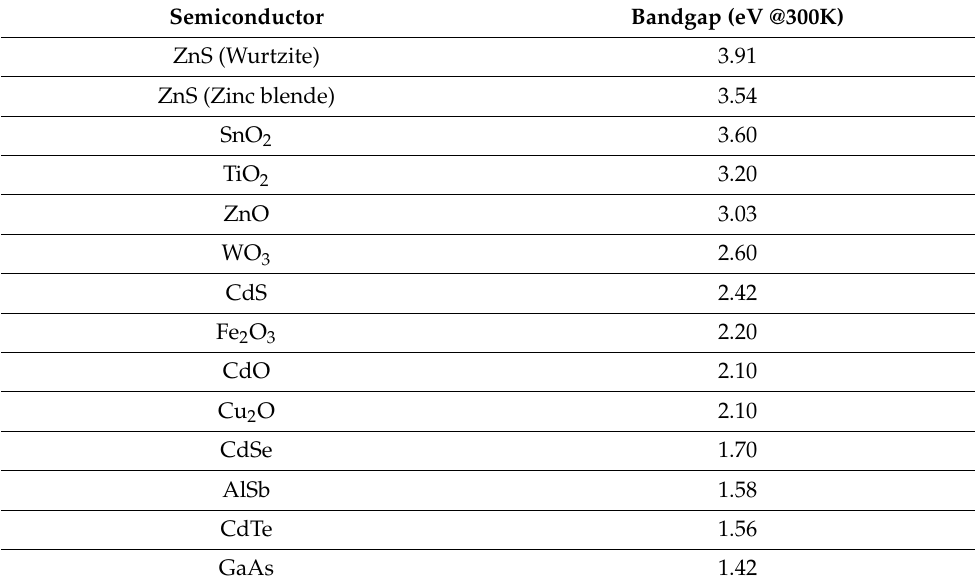
Table 1. Bandgaps of semiconductors (adapted from